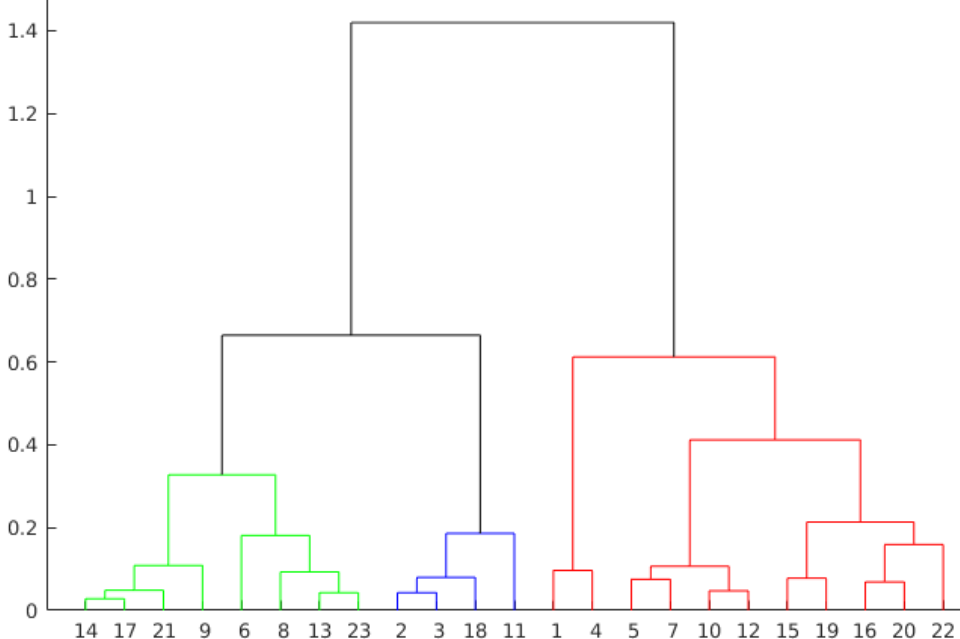
Figure 7. Dendrogram representation of presentation 3 in year